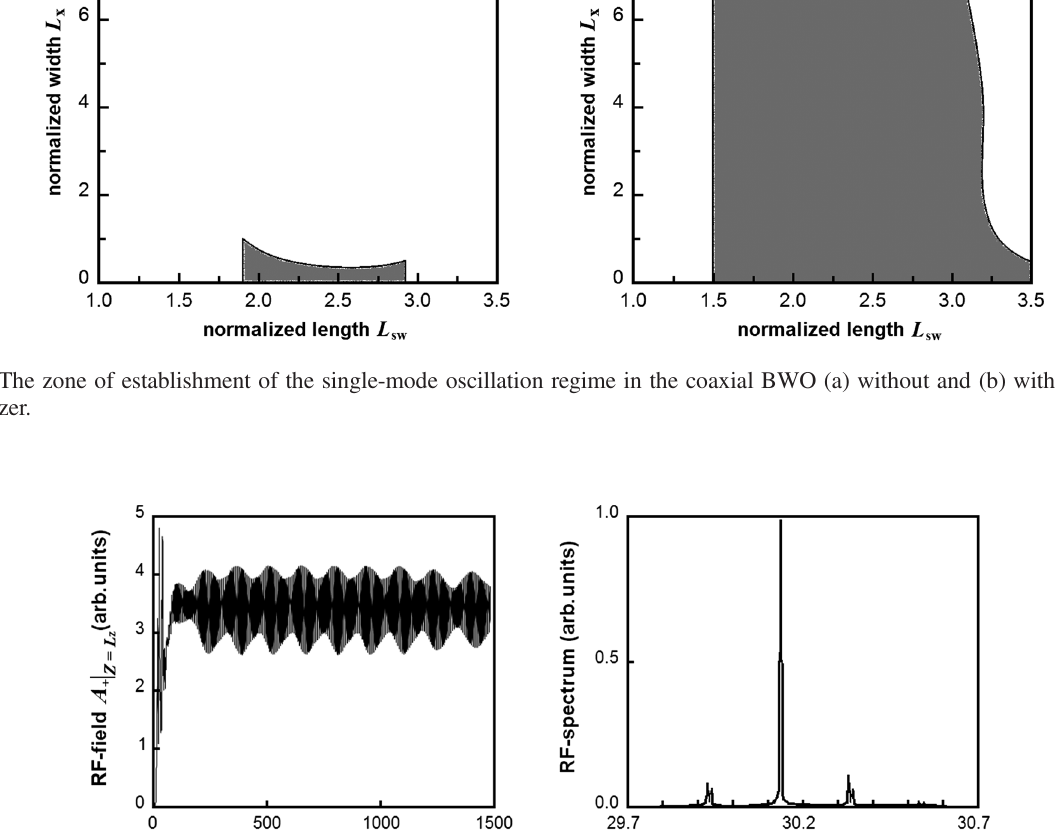
FIG. 6. The results of simulations of the coaxial BWO with a 2D Bragg synchronizer for a high beam current I